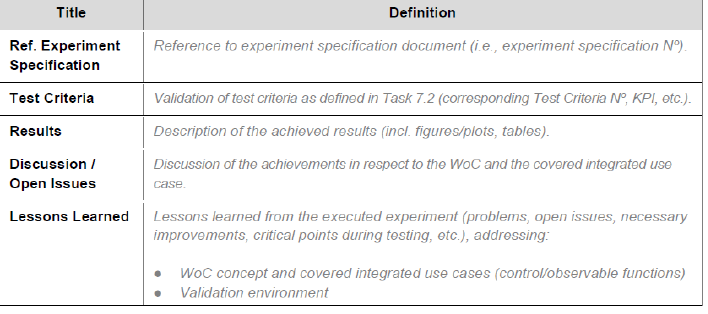
Figure 8. Experiment reporting template used in ELECTRA